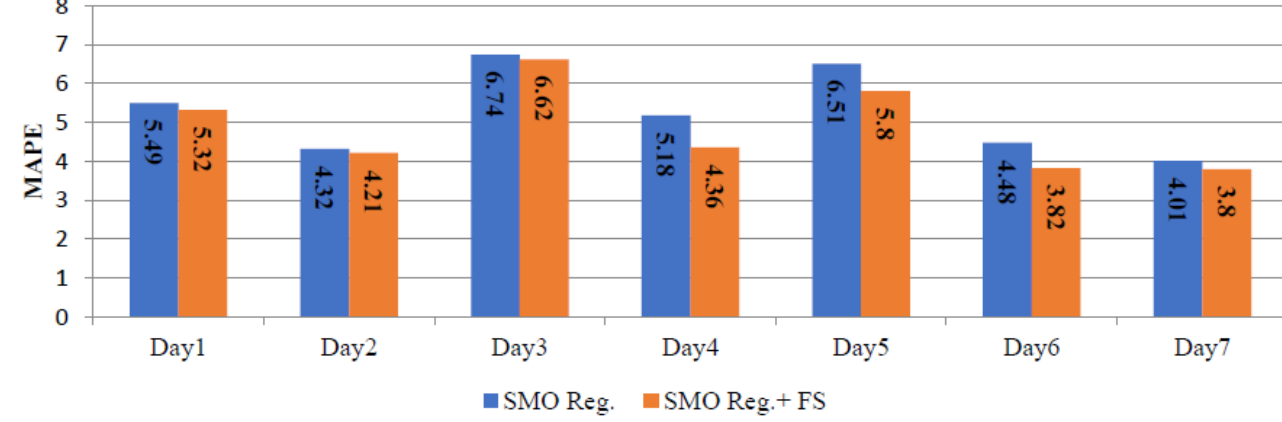
Figure 6. Daily MAPE corresponding to SMO reg. and SMO reg.+ FS for winter season.